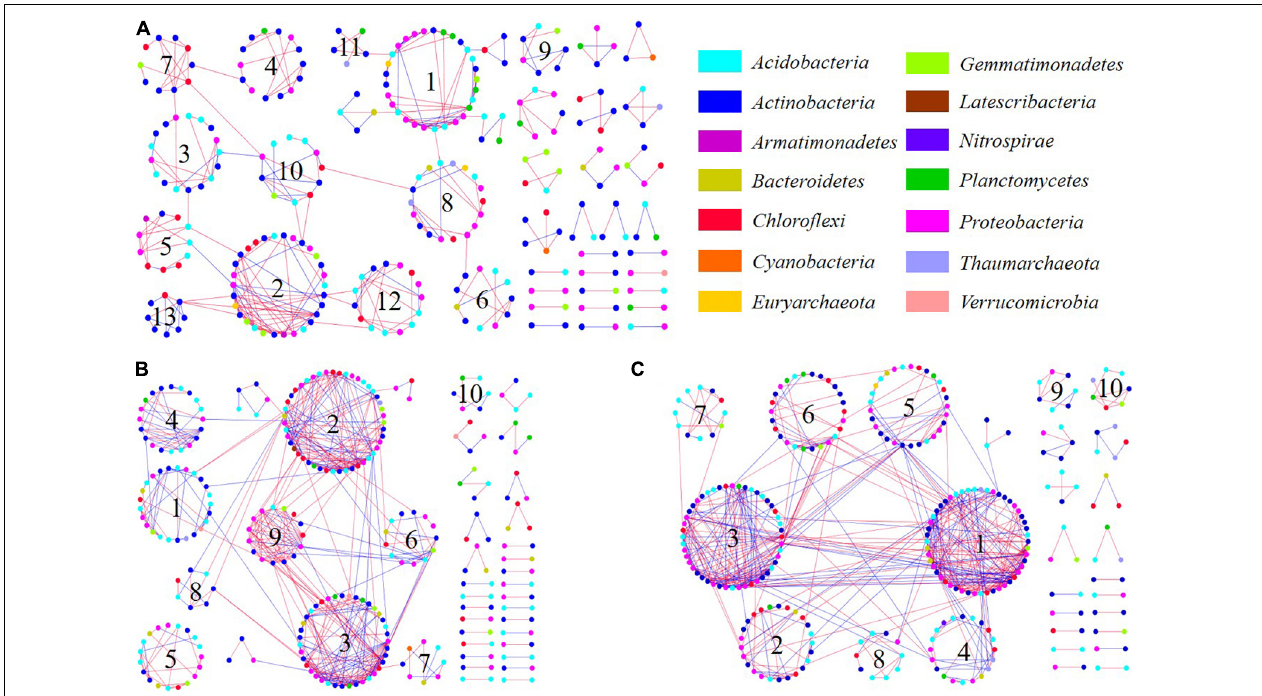
FIGURE 7 | Soil bacterial molecular ecological networks and module structure of (A) the bottom of the slope, (B) the middle of the slope, and (C) the top of the slope. The connecting line represents the interaction of the target level on phylum; colors blue and red represent positive and negative interactions, respectively.